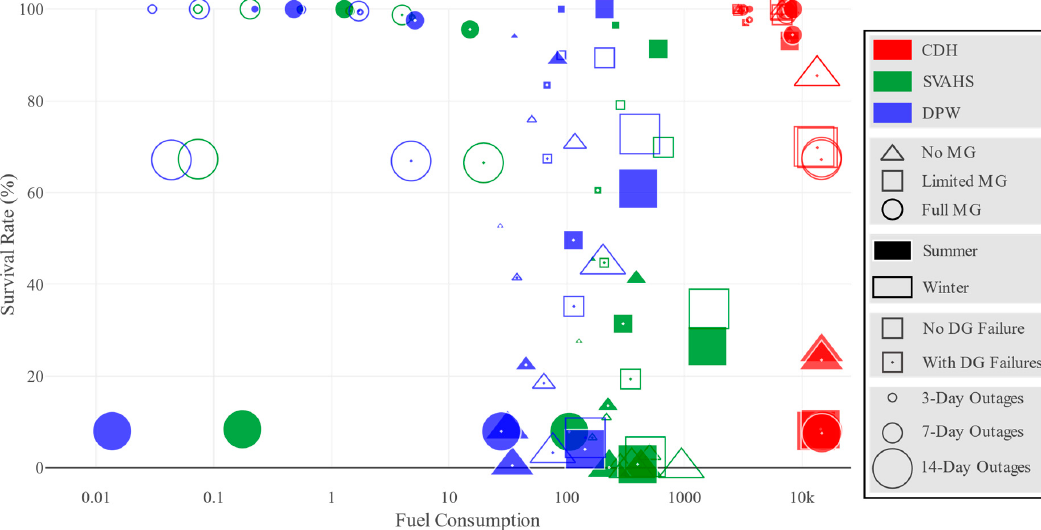
Figure 15. Survival rate and fuel consumption of the system with PV arrays at CDH.